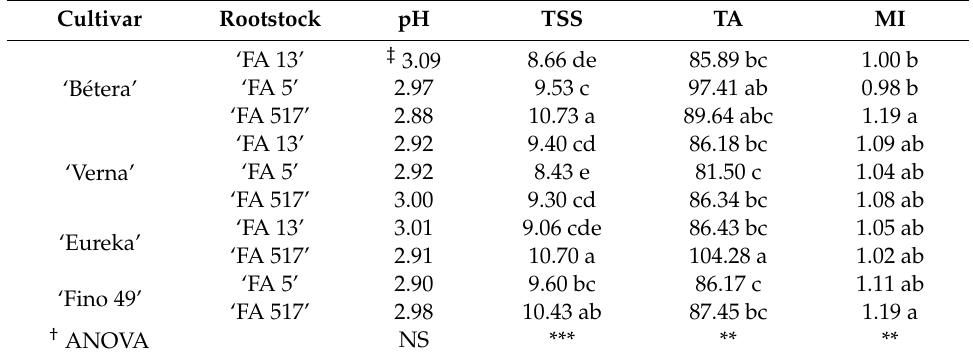
Table 3. E ff ect of di ff erent rootstocks on lemons (‘B é tera’, ‘Verna’, ‘Eureka’ and ‘Fino 49’) fruit total soluble solids (TSS, ◦ Brix), titratable acidity (TA, g citric acid L − 1 ), pH and maturity index (MI).